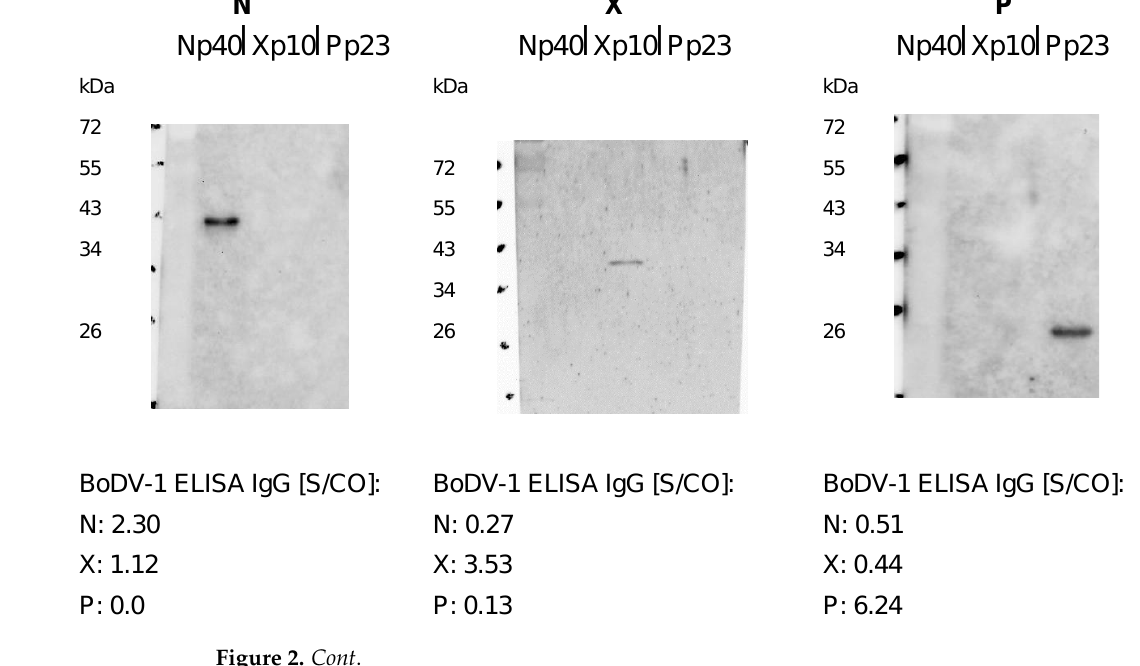
Figure 2. BoDV-1 immunoblots of selected samples with reactive ELISA results. Immunoblots were performed using the same recombinant viral proteins as used for ELISA. Under ( A ), confirmations of antigen-directed IgG antibodies by immunoblots are shown for Np40 protein (His-tagged) on the left, for Xp10 protein (tagged with a 26kDa GST-tag) in the middle, and for Pp23 (His-tagged) on the right. The values given below represent ELISA screening results of the corresponding sample. The probability of an immunoblot band increased with higher S/CO values of the screening ELISA for all used antigens ( B ). Shown are the best-fit lines for logistic regression (0 = no immunoblot band, 1 = immunoblot band) with 95% confidence intervals. Vertical dotted lines represent the ELISA cut- off.